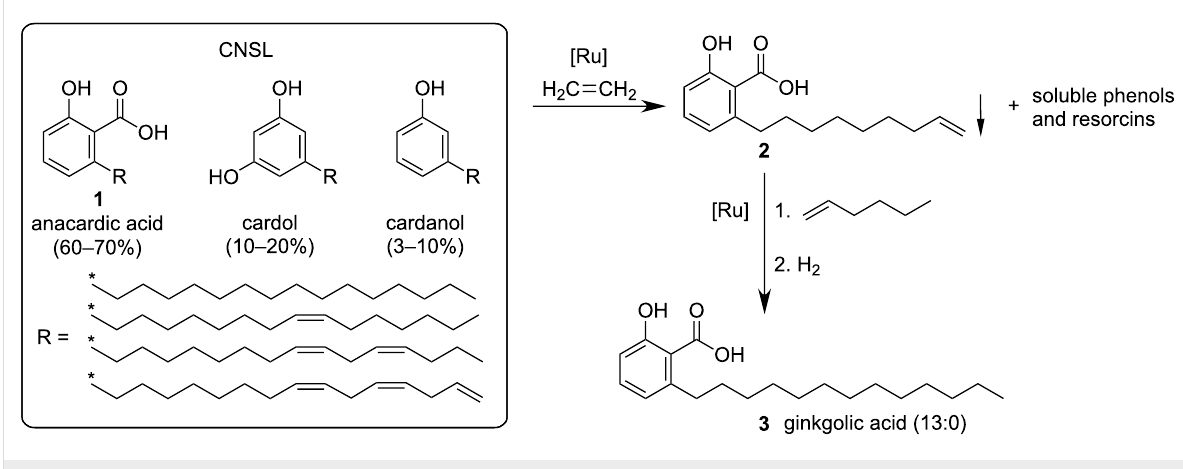
Scheme 1: Targeted conversion of CNSL into a tyrosinase